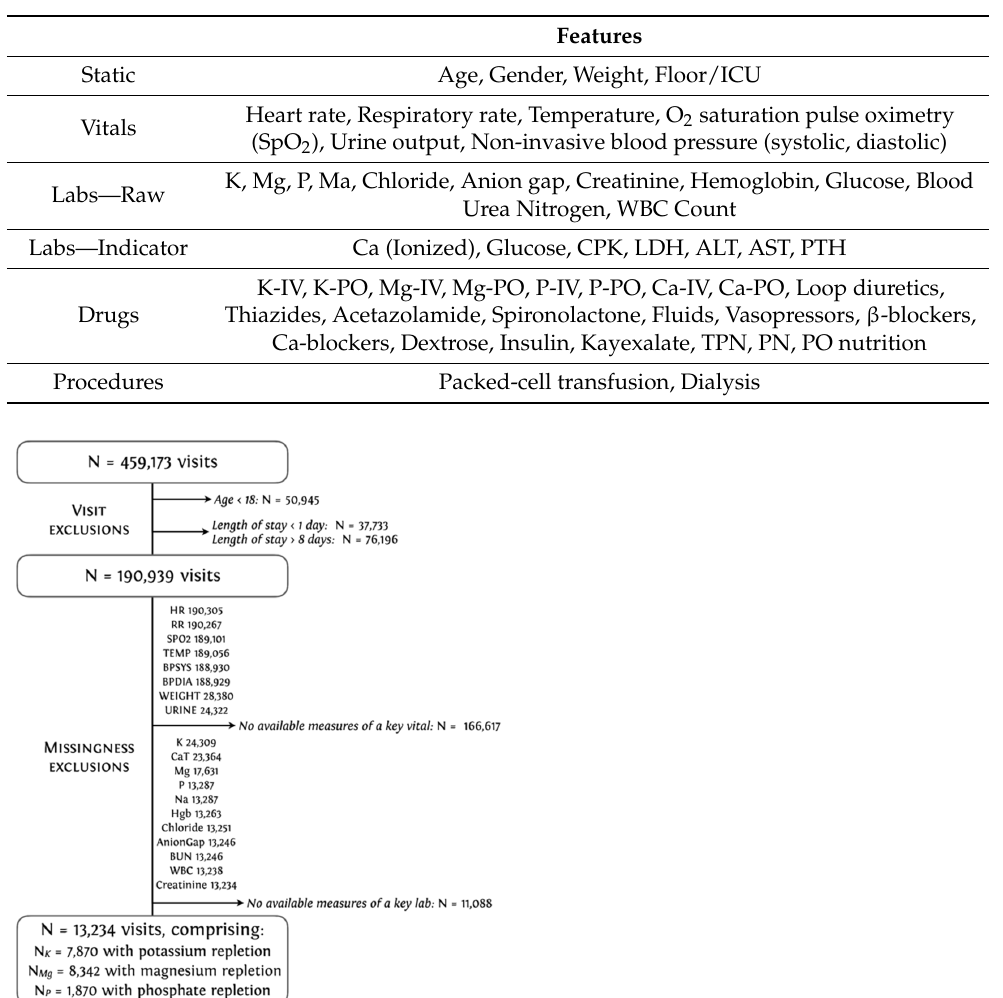
Table 1. Selected 52 clinical features from patient EHRs based on their influence on electrolyte levels. We also included imputed measurements at each 6 h interval for a number of key vitals and labs.